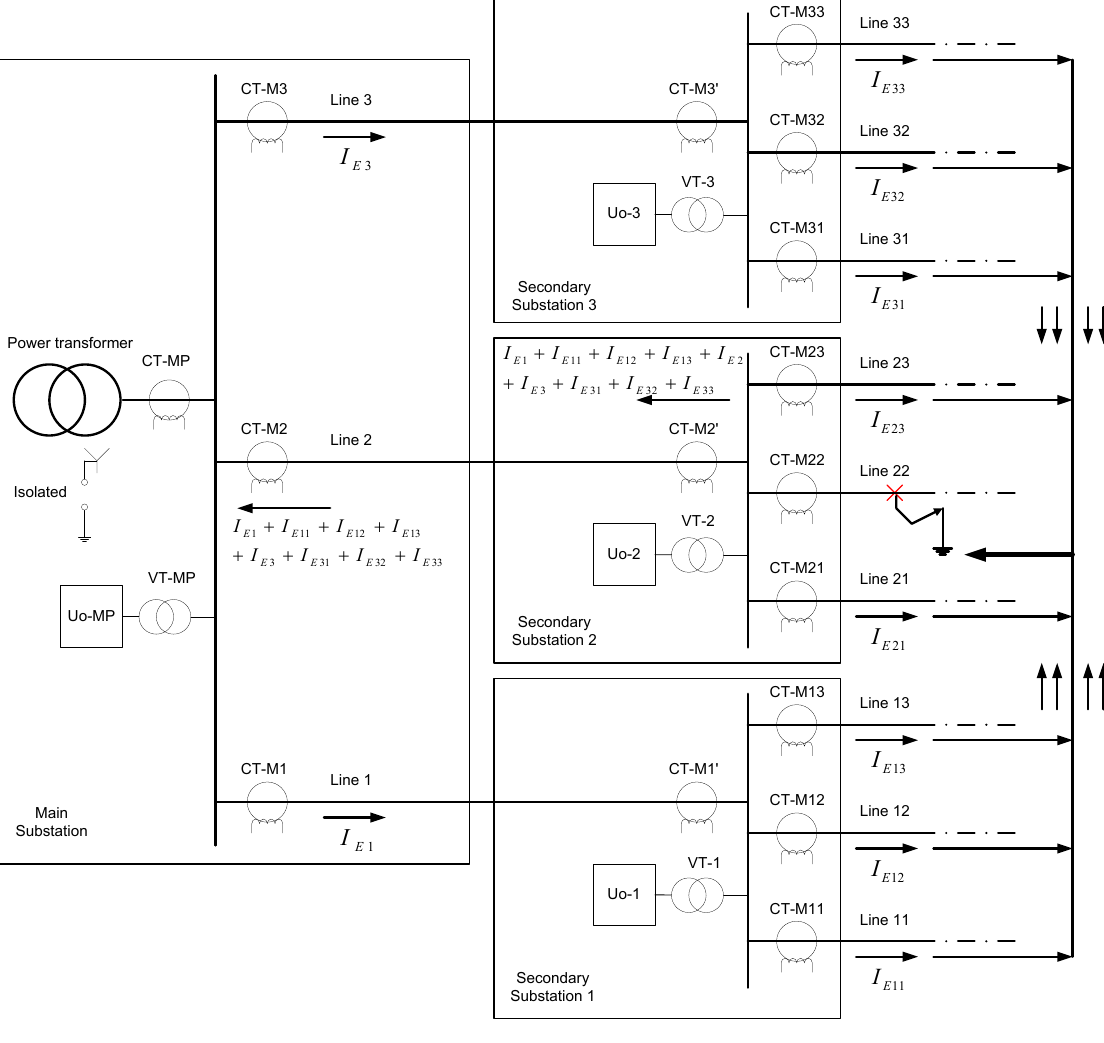
Figure 9. Highest ground fault currents at neutral undergrounded network with secondary substations. SPGF at Line